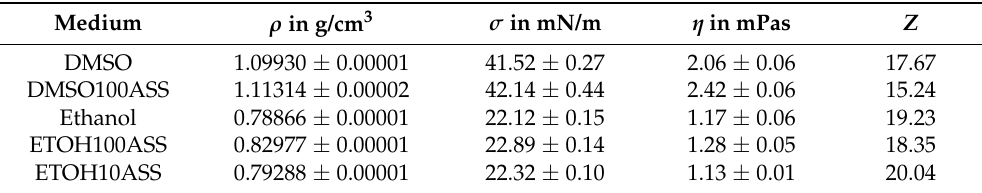
Table 2. Overview of averaged values of measured fluid properties (means ± standard deviations, n = 3 each), the nozzle diameter and calculated Z numbers. Z numbers are suitable for inkjet printing. The appearance of satellite droplets is